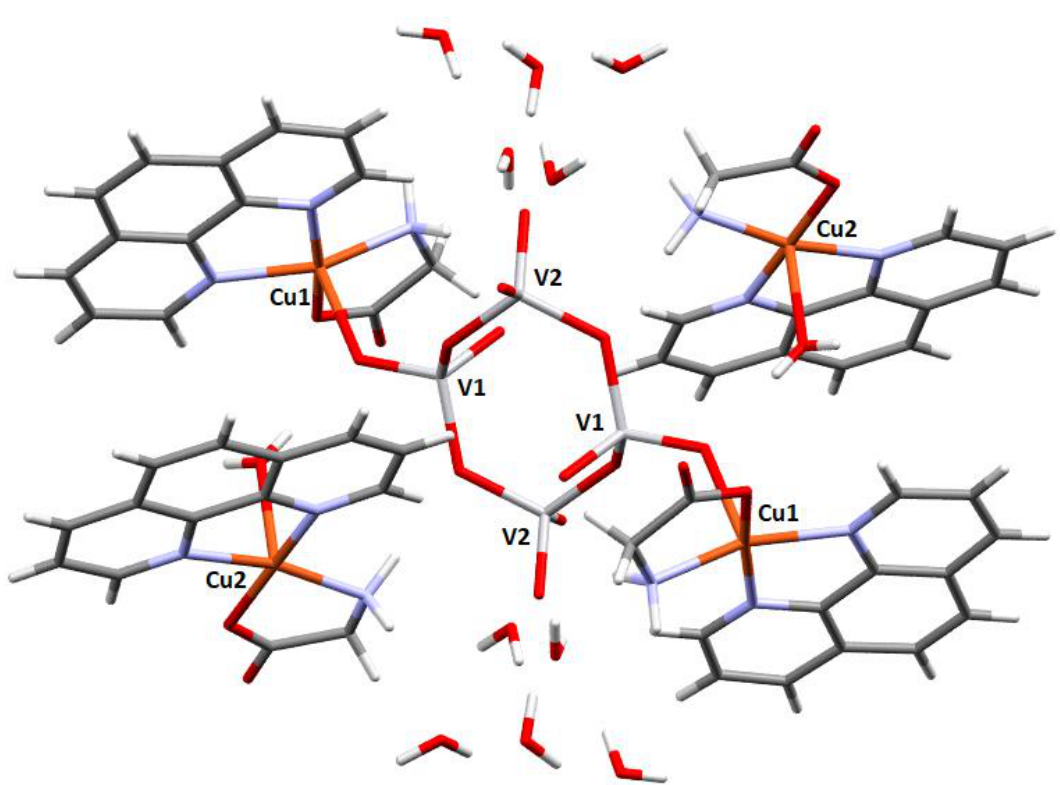
Figure 1. Capped stick representation of the molecular structure of Compound 1.